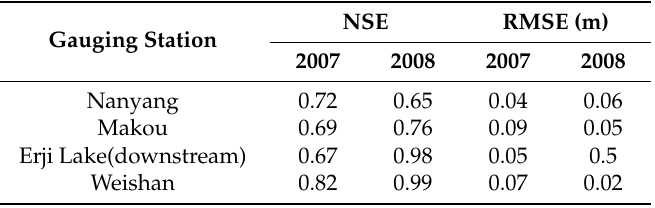
Figure 3. Comparison between the observed and simulated water levels at selected locations for flood events of 2007 under calibration conditions (left) and 2008 under validation conditions (right). Red dots represent observed data, and black lines represent the Nansi Lake Flooding and Waterlogging Simulation Model simulation results. Table 1. Statistical evaluation of the model performance in simulating the water levels at selected gauging stations for the flood events in 2007 and 2008. NSE: Nash–Sutcliffe efficiency coefficient, RMSE: root mean square